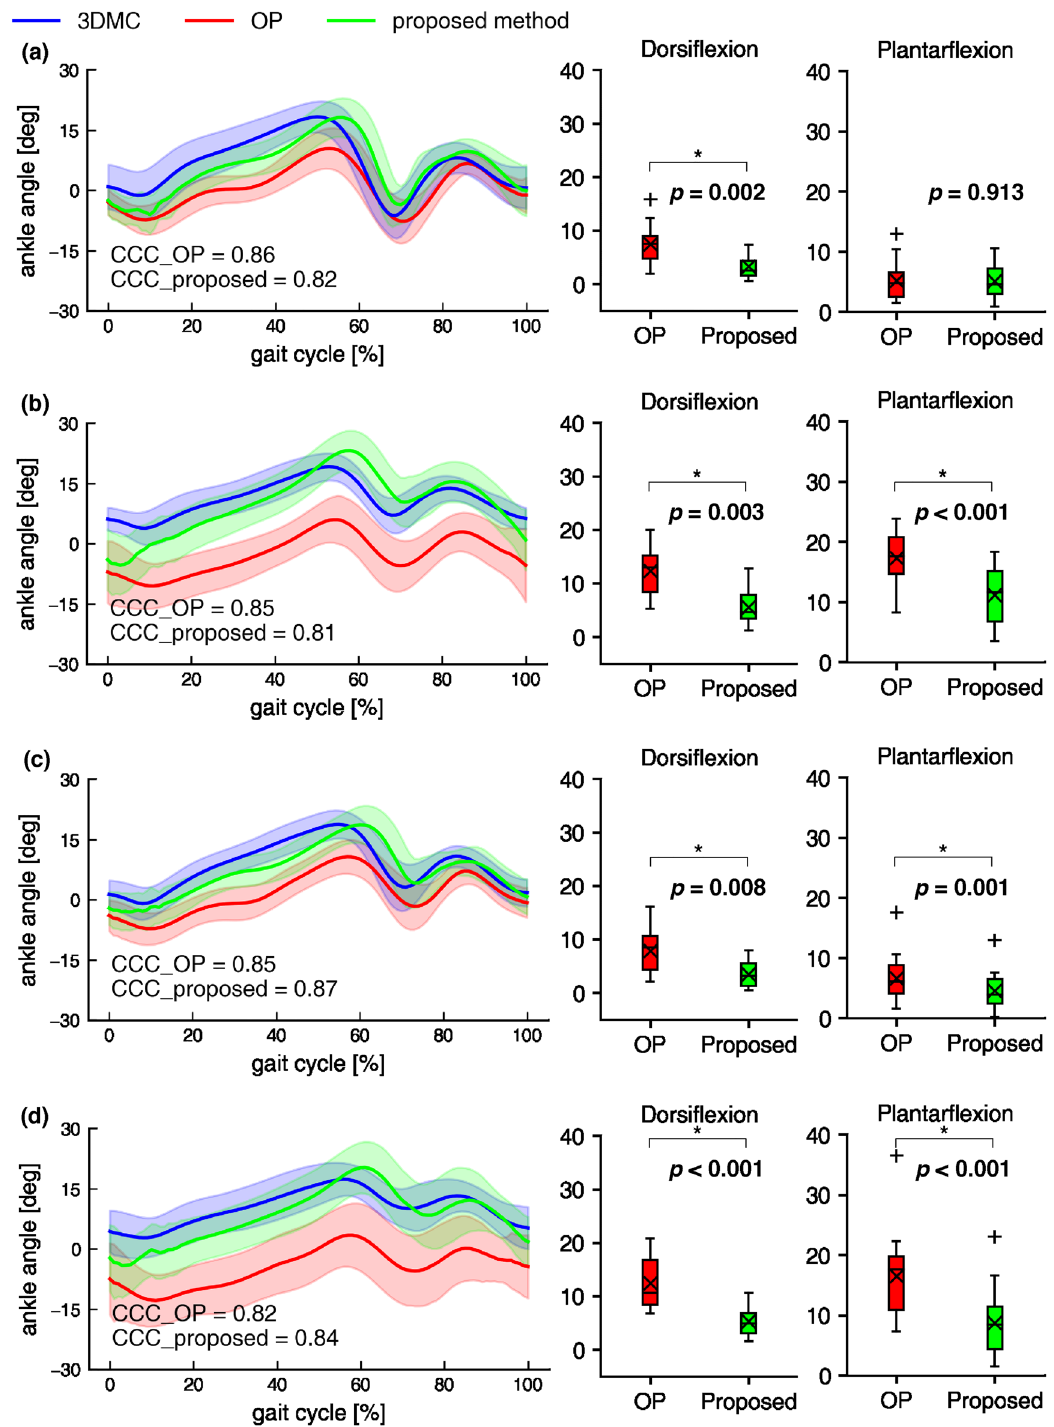
Figure 5. Ankle dorsiflexion-plantarflexion angle by the three measurement methods and MAE of peak joint angles in each condition. Left side figures show ankle joint angles of temporal changes during gait under the four conditions. Self-selected speed with normal ( a ) and large FPA ( b ) condition. Slow speed with normal ( c ) and large FPA ( d ) condition. The shade is presented as 1 SD. Flexion is defined as positive. The right side box plots show MAE between 3DMC and other methods. Red and green box plots mean MAE using OP and proposed method, respectively. Boxes and horizontal lines represent ranges of Q1–Q3 and median values. × and + indicates mean and outlier, respectively. *Indicates that proposed method significantly decreased MAE compared with MAE using OP ( p <